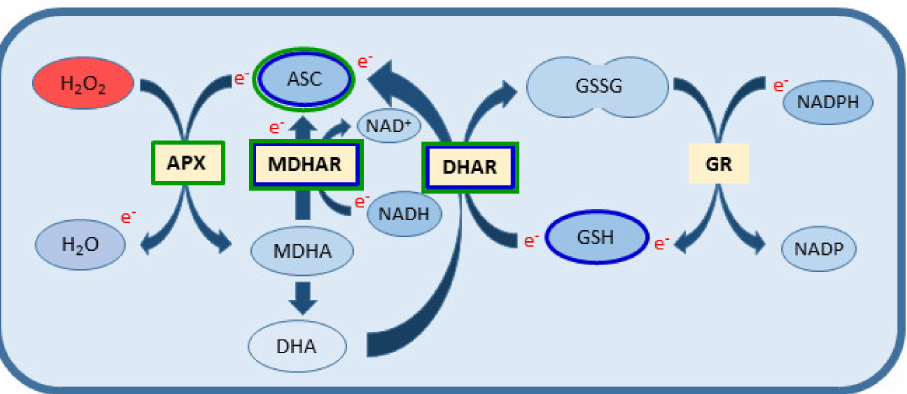
Figure 5. Summary of the work showing the role of the ascorbate–glutathione cycle in the scavenging of ROS (H 2 O 2 ) generated during ME-induction in microspores of the responsive triticale line (DH28) and barley cultivar (cv. Igri). The generated H 2 O 2 is initially reduced via the oxidation of reduced ascorbate (ASC) in a reaction catalysed by APX. Two MDHA molecules spontaneously dispropor- tionate into ASC and dehydroascorbate (DHA). Both MDHA and DHA can be reduced back to ASC in reactions catalysed by MDHAR and DHAR, where GSH and NADH are used as electron donors. Oxidized glutathione (GSSG) is converted back to its reduced form by GR using NADPH as an electron donor. Ascorbate–glutathione cycle components, which are largely involved in the process of ME-induction in triticale and barley are marked with the following colour outlines: dark blue for triticale and green for barley. APX—ascorbate peroxidase; ASC—reduced ascorbate; DHA— dehydroascorbate; DHAR—dehydroascorbate reductase; GR—glutathione reductase; GSH—reduced glutathione; GSSG—oxidized glutathione, glutathione disulphide; MDHA—monodehydroascorbate; MDHAR—monodehydroascorbate reductase; NAD(P)H/NAD(P)+—nicotinamide adenine dinu- cleotide (phosphate) reduced/oxidized; e − —transferred